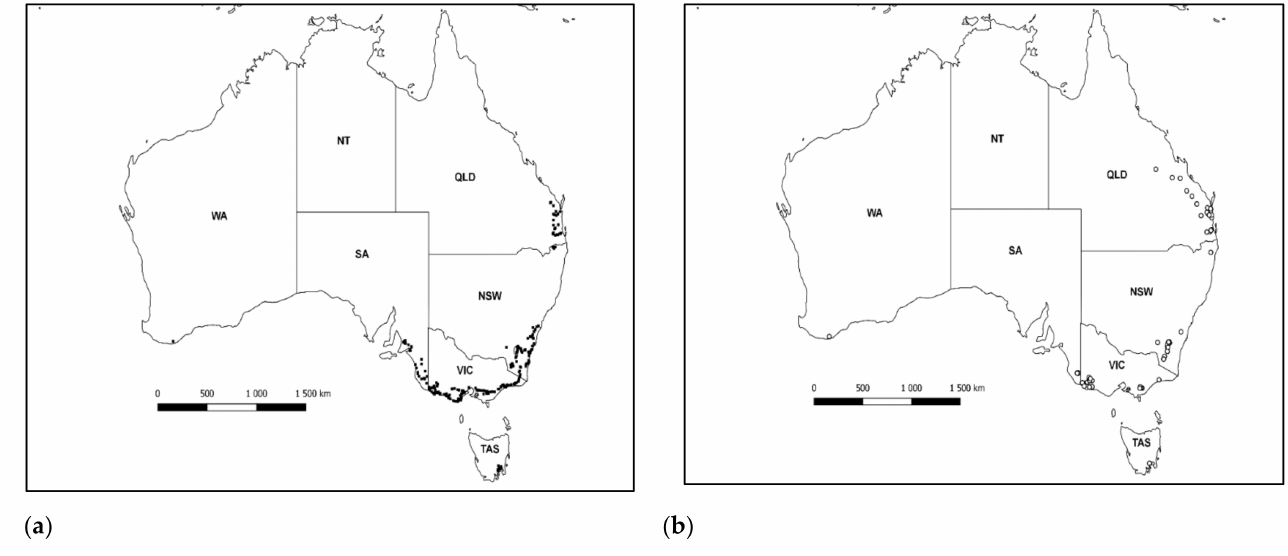
Figure 1. Geographical representation of the collection points where searches were made for the presence of Gonipterus species and their parasitoids: ( a ) collection points where searches were made for Gonipterus but not found; and ( b ) where Gonipterus was